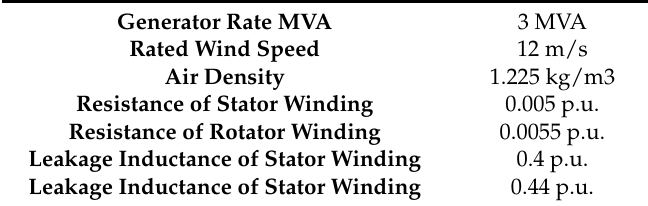
Table 3. Parameters of the wind turbine.